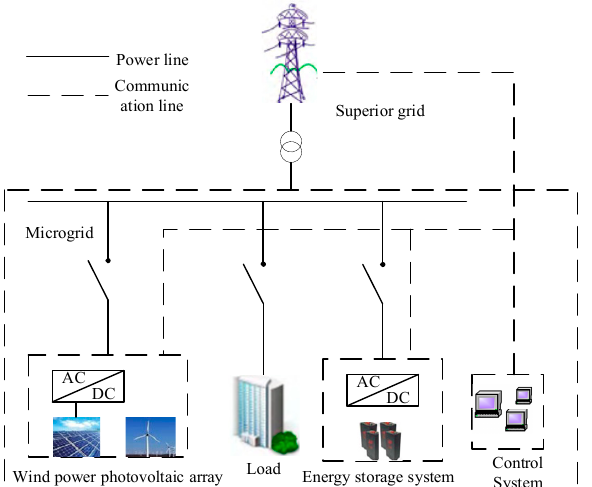
Figure 3. Typical structure diagram of PV and wind power-based microgrid.